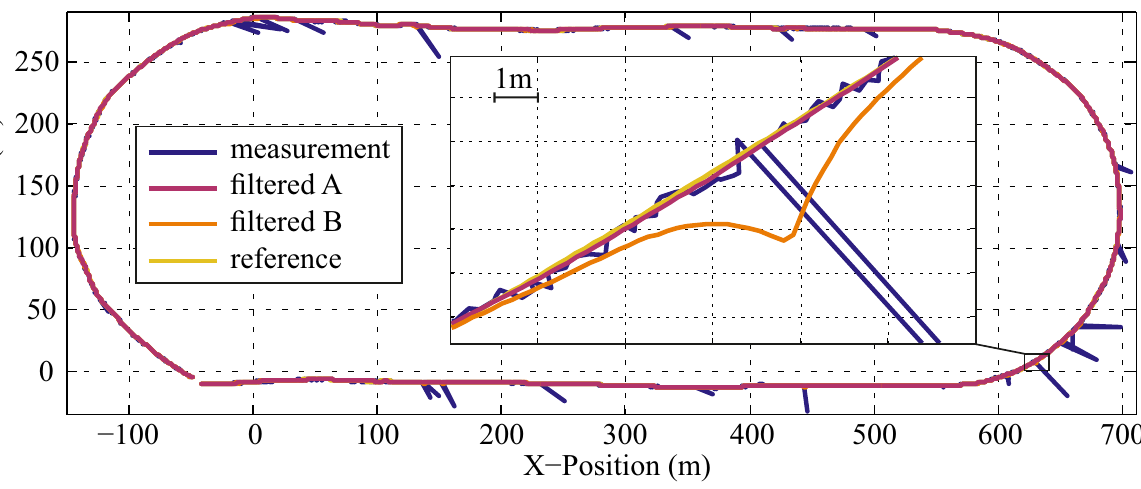
Figure 6. Example plot of the measured and filtered data with magnified detail of the lower right corner of the track. The filtered curves were processed using a constant lag of 500 ms. The measurements were disturbed by Gaussian noise and outliers. Using the proposed method ( A ), the Gaussian noise was reduced, and there was no visible effect of the outliers in the observations. When outliers were not considered in the filtering process ( B ), the filter is susceptible to the outliers, and the filtered curve deviated from the reference. In the depicted case, the deviation added up to several meters.